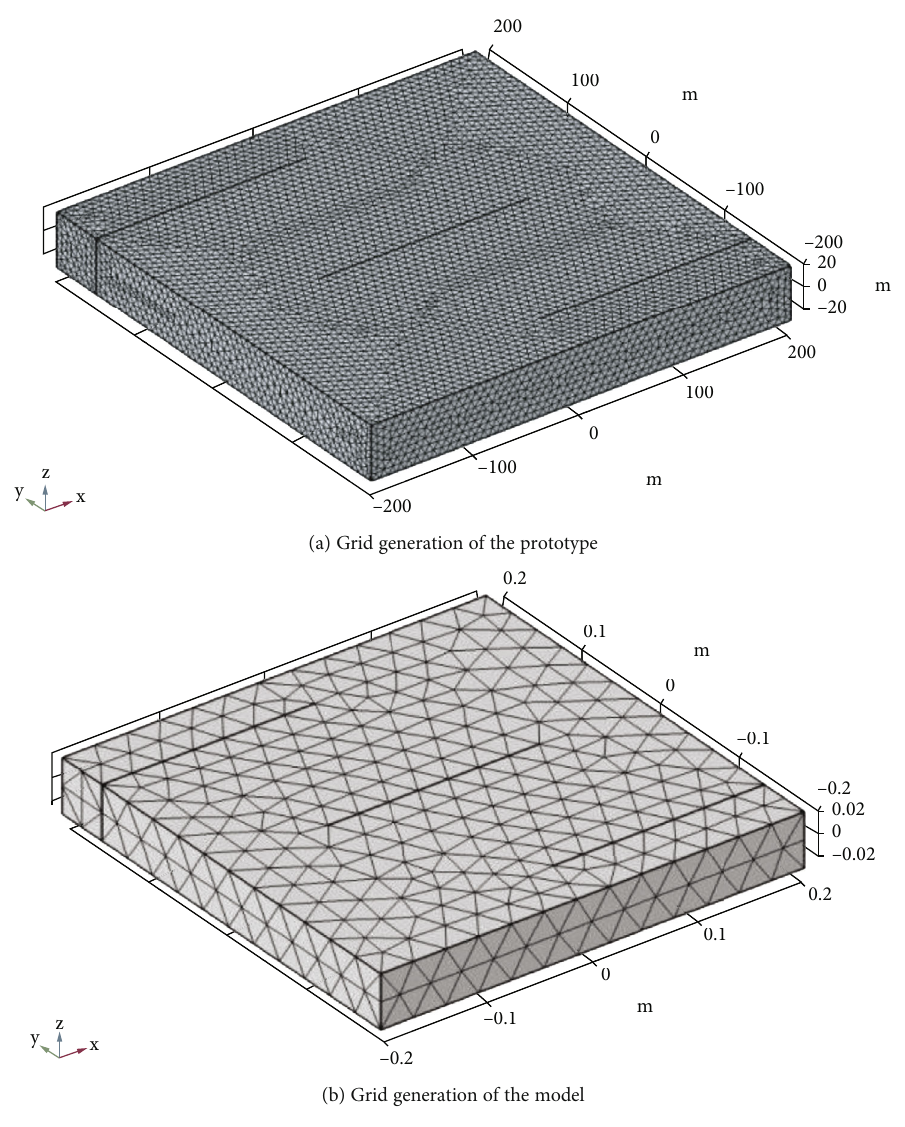
Figure 3: Grid generation of the prototype and the